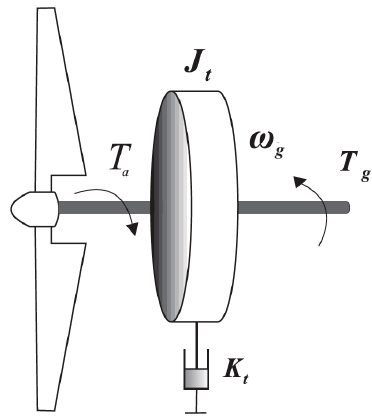
Figure 1. One-mass model of a wind